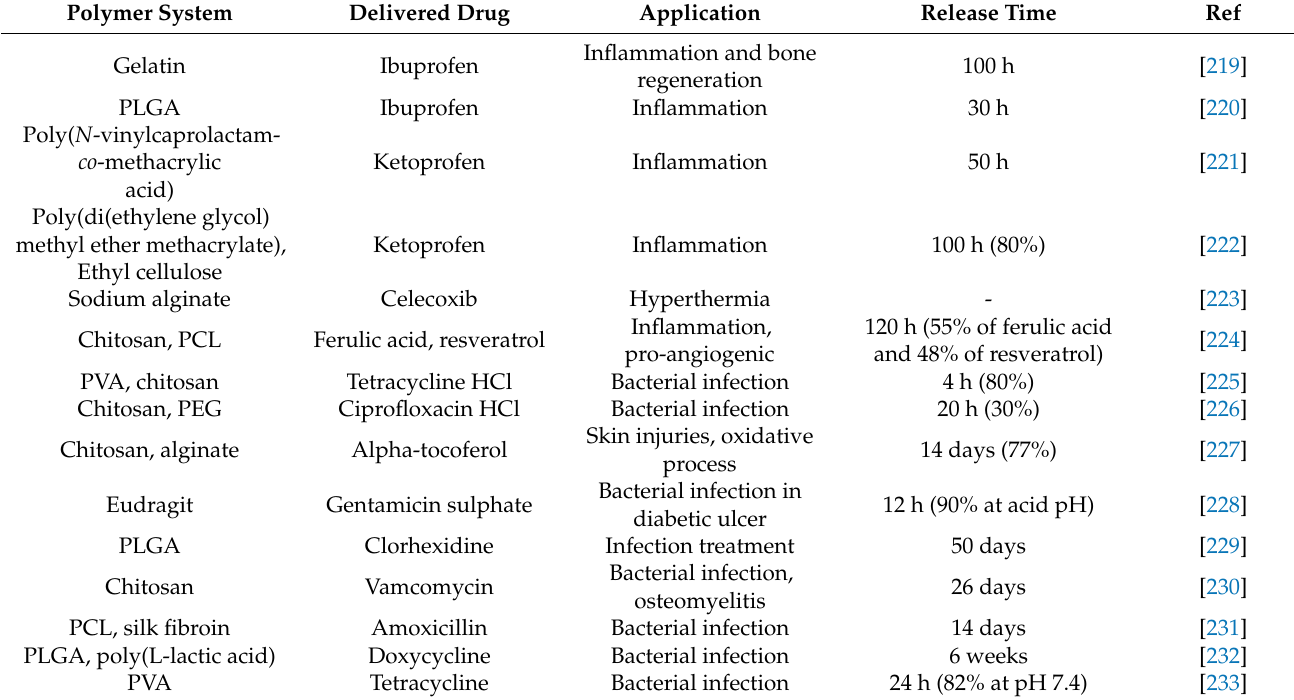
Table 1. Thermo-responsive scaffolds for drug delivery in wound